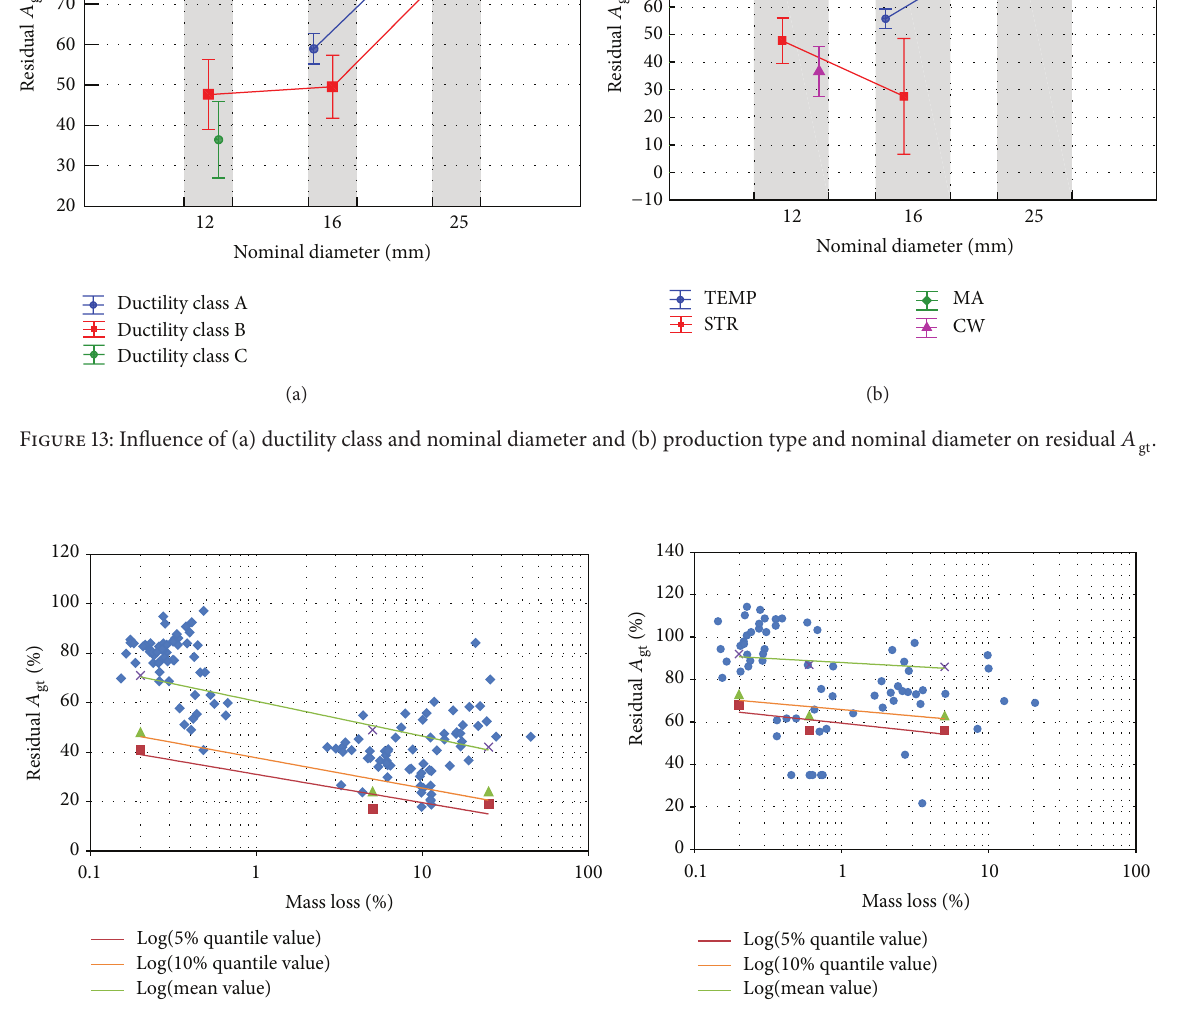
for nominal diameter 16 mm (5%, 10%, and 50% quantile). (b) Influence of mass loss on gt